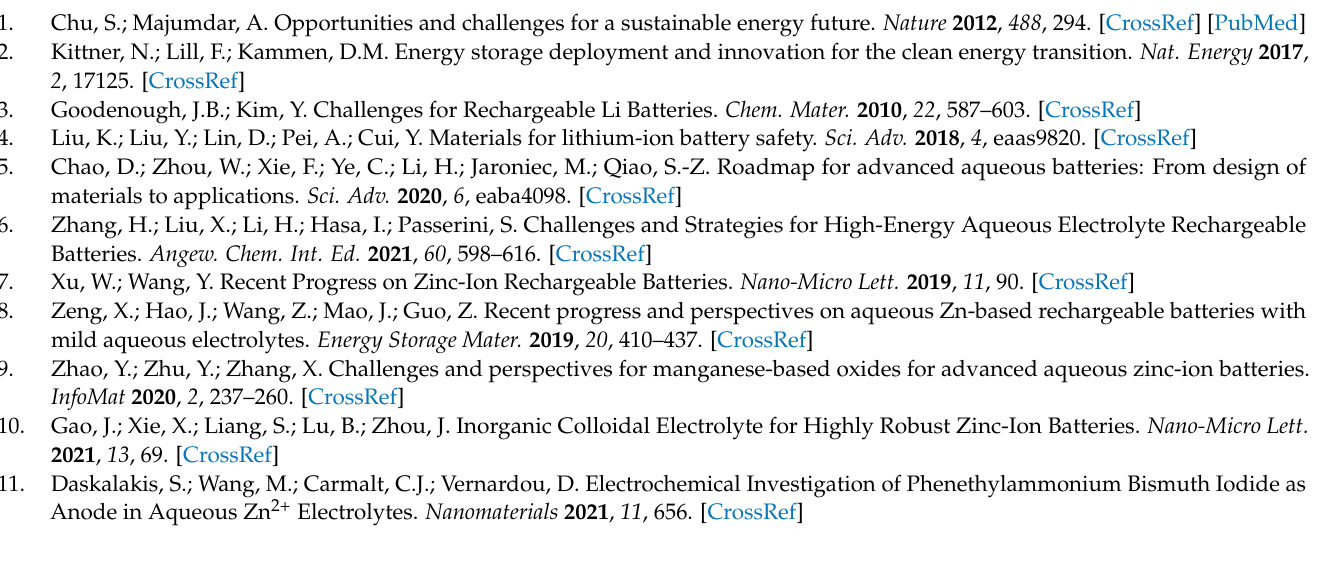
Figure S3: SEM, TEM images and EDX results; Figure S4: V 2p XPS spectrum and SEM image of com- mercial V 2 O 5 ; Figure S5: CV curves; Figure S6: GCD profiles at 1.0 A g − 1 ; Figure S7: Electrochemical performance of commercial V 2 O 5 ; Figure S8: Electrochemical performance of V 2 O 5 nanorods annealed at 500 ◦ C; Figure S9: ex-situ XPS spectra of V 2 O 5 · n H 2 O nanorods; Figure S10: SEM image of V 2 O 5 · n H 2 O nanorods after 200 cycles; Table S1: Electrochemical performance of the reported orthorhombic V 2 O 5 ma- terials in aqueous Zn batteries. References [23,24,35–37,58,59] are cited in the supplementary